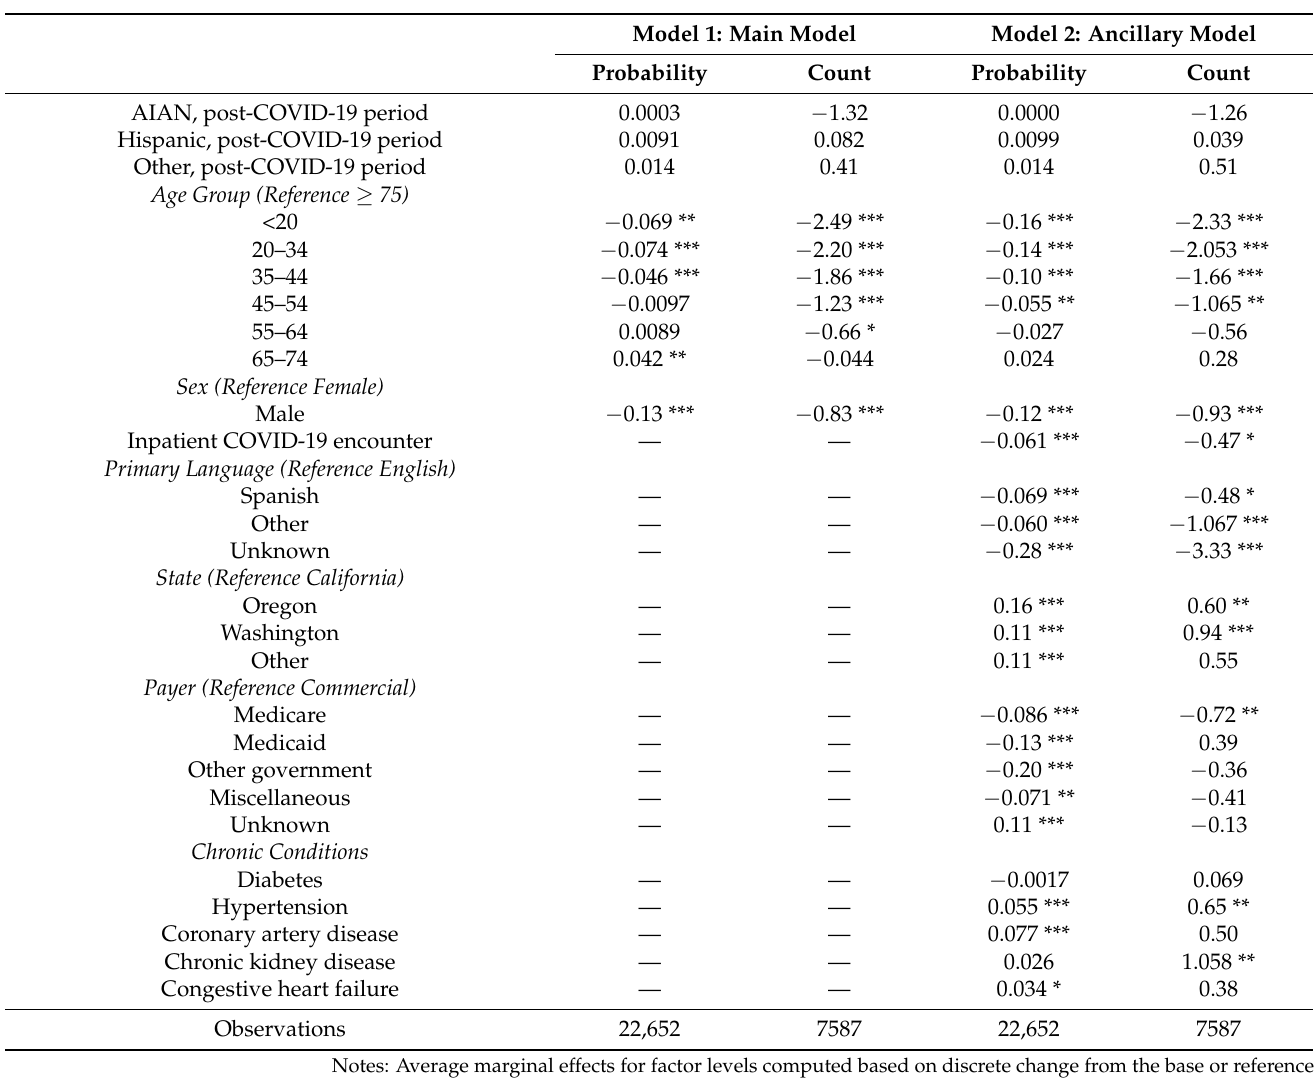
Table 4. Cont. Model 1: Main Model Model 2: Ancillary